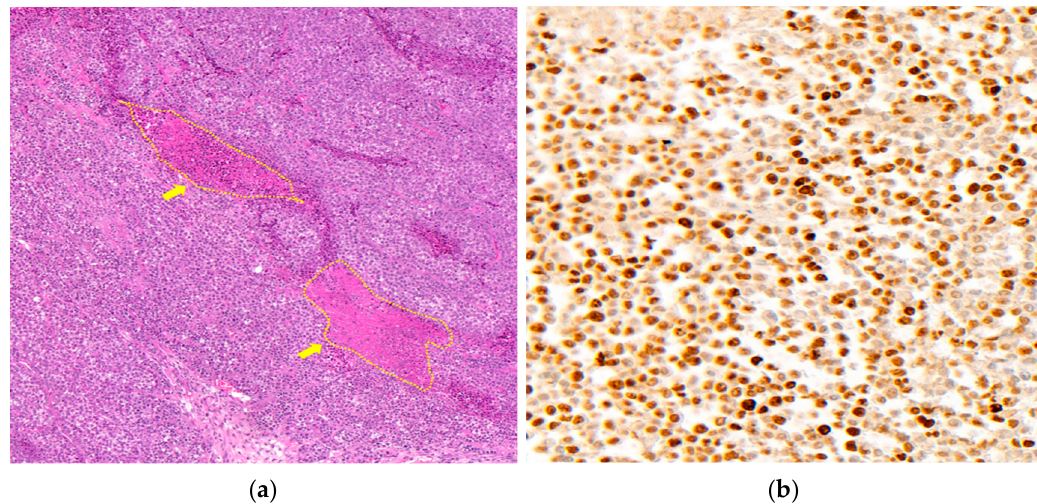
Figure 6. Pathological analysis of resected tumor tissues. ( a ) Representative example of H&E staining of A549 tumor tissues with necrosis (×100). Yellow arrows indicate necrosis area with inflammation. ( b ) Representative example of Ki-67 immunohistochemistry (×400). Tumor cells with brown colored nucleus were counted as positive. Table 2. Comparison of necrosis ratio and Ki-67 positive index of tumor tissues between Air group and 2% Sevo group.